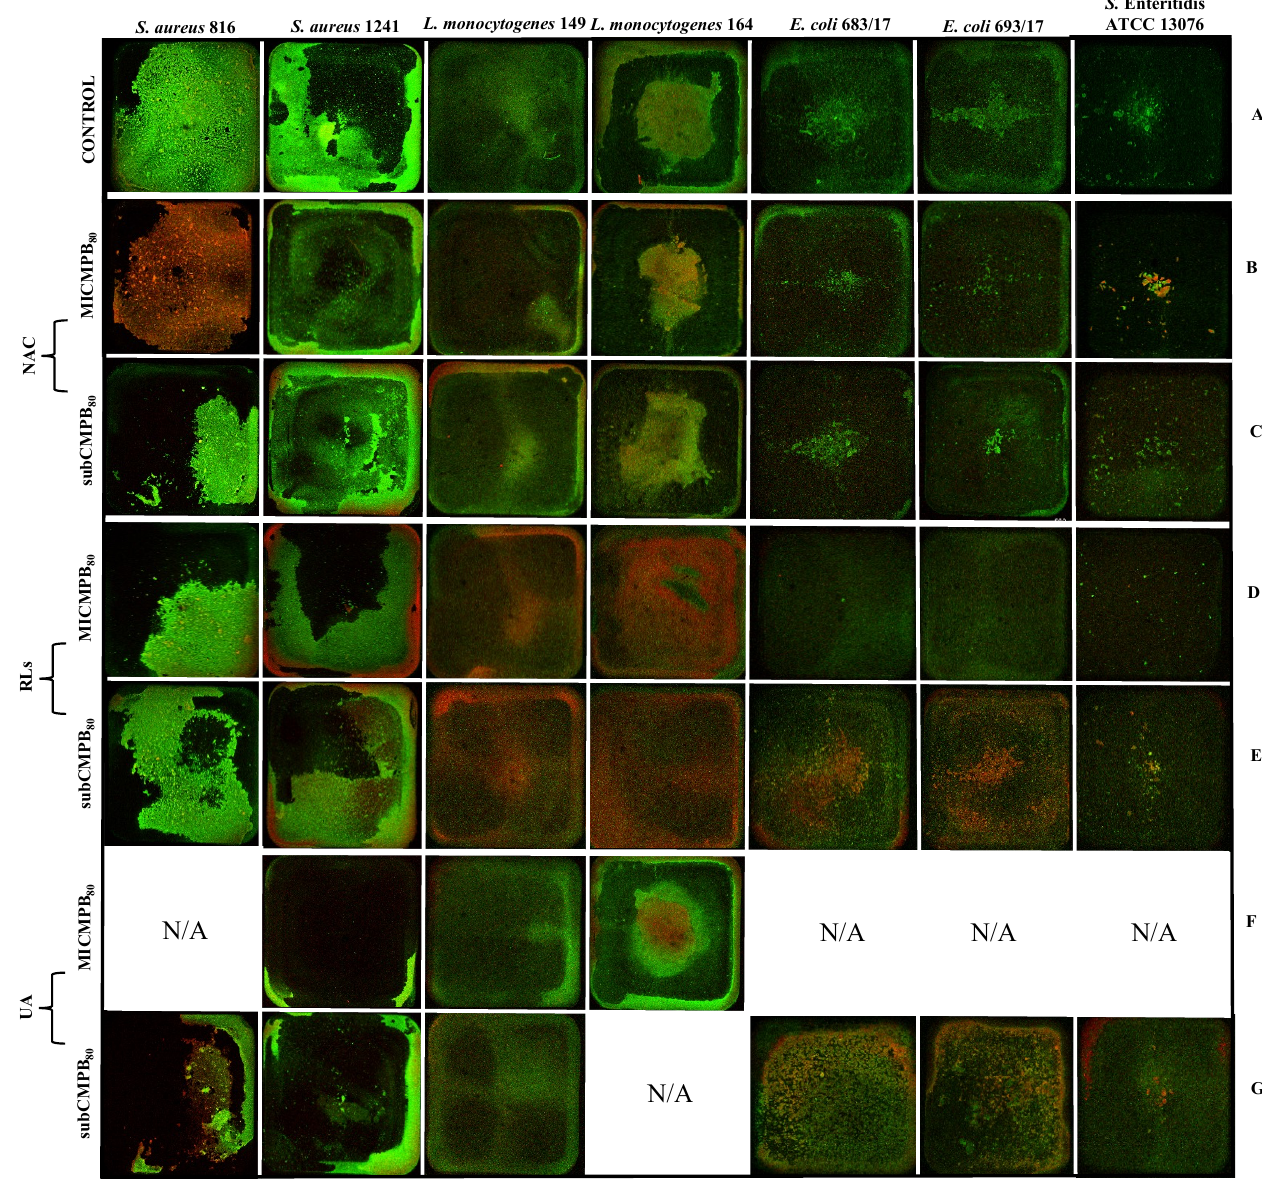
Figure 4. Representative projections of biofilm mass at the bottom of the microtiter wells for Staphylococcus aureus 816 and 1241, Listeria monocytogenes 149 and 164, E. coli 683/17 and 693/17, and Salmonella Enteritidis ATCC 13076 after 20 h of treatment with the respective antimicrobial compounds. ( A ): positive control; ( B , C ): N -Acetyl- L -cysteine (NAC); ( D , E ): rhamnolipids (RLs); ( F , G ): usnic acid (UA). Prior to imaging, microtiter wells were stained with LIVE/DEAD ® BacLight™ Bacterial Viability Kit distinguishing live cells (green) and membrane-compromised cells (red). Images represent the surface of the well 7.4 × 7.4 mm 2 . For some strains, the minimum inhibitory and subinhibitory concentrations could not be established; thus, they were not involved in the analysis. N/A marks concentration was not applied.